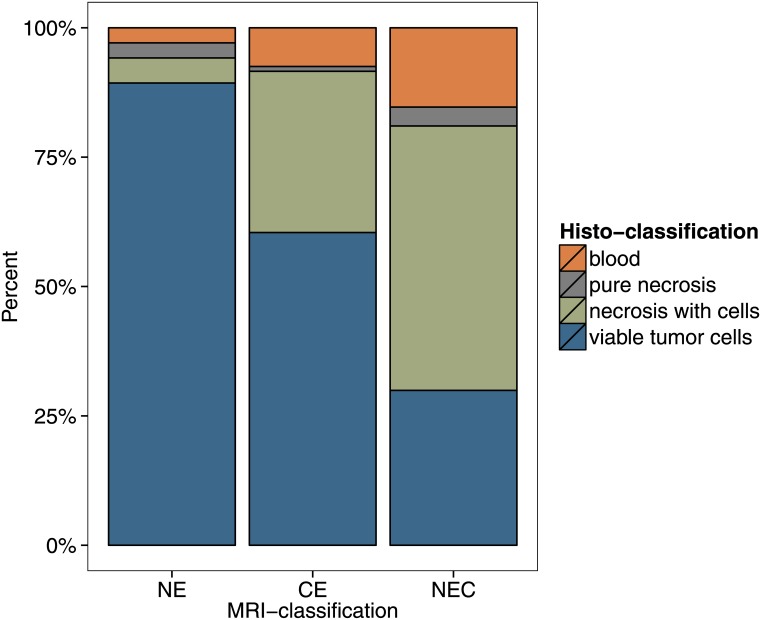
Histological composition of the different MRI classifications.For all 561 biopsy samples, the relative frequency of the different histologic classifications within each MRI classification is displayed. NE = non-enhancing part on cT1; CE = contrast enhancement on cT1; NEC = Necrosis on cT1.